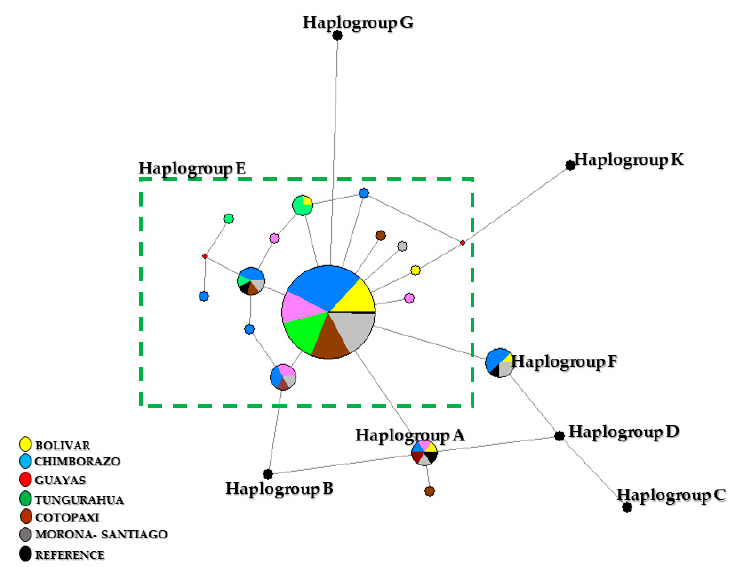
Figure 1. Median-joining network for the Ecuadorian Creole chicken breed compared with reference sequences from Ceccobelli et al. [9]. Circled areas are proportional to the haplotype frequencies and colors identify the province of the samples.